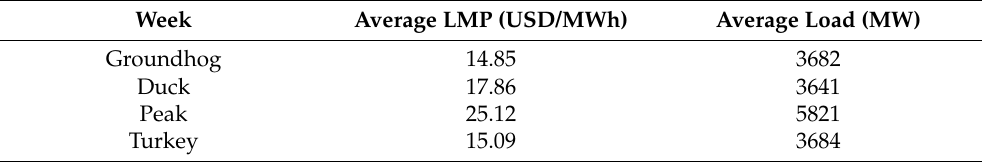
Table 7. Load-weighted average LMP (USD/MWh) over all nodes in the RTS-GMLC without EVs. Week Week